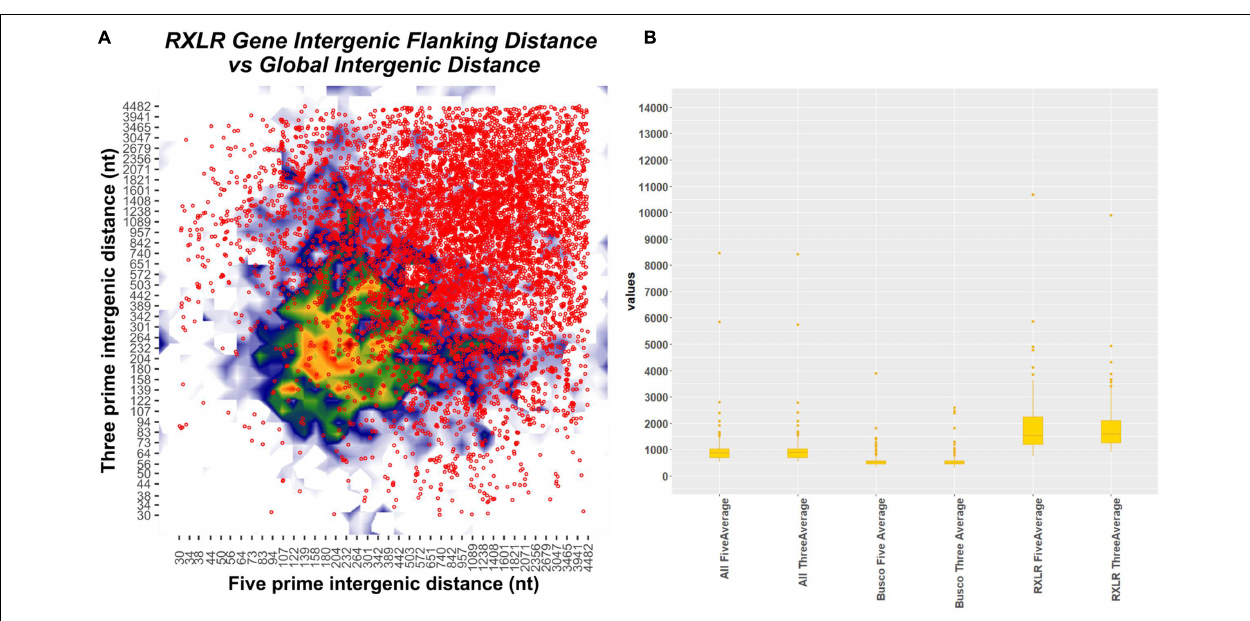
Frontiers in Microbiology |